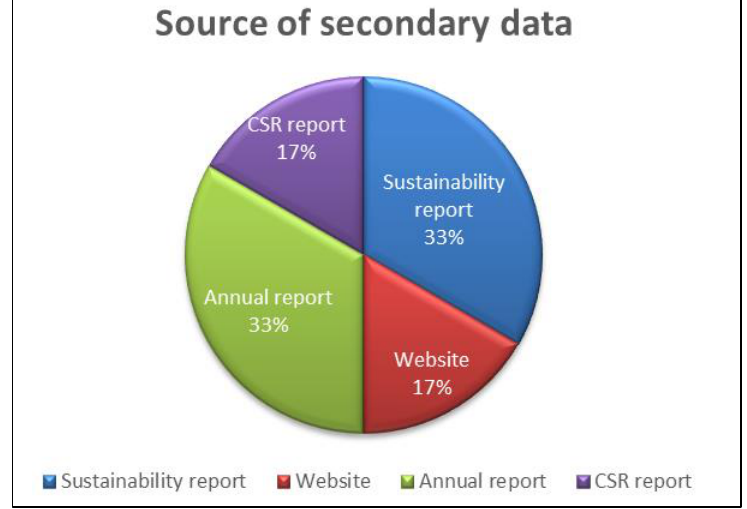
Figure 1. Distribution of data analysed by source